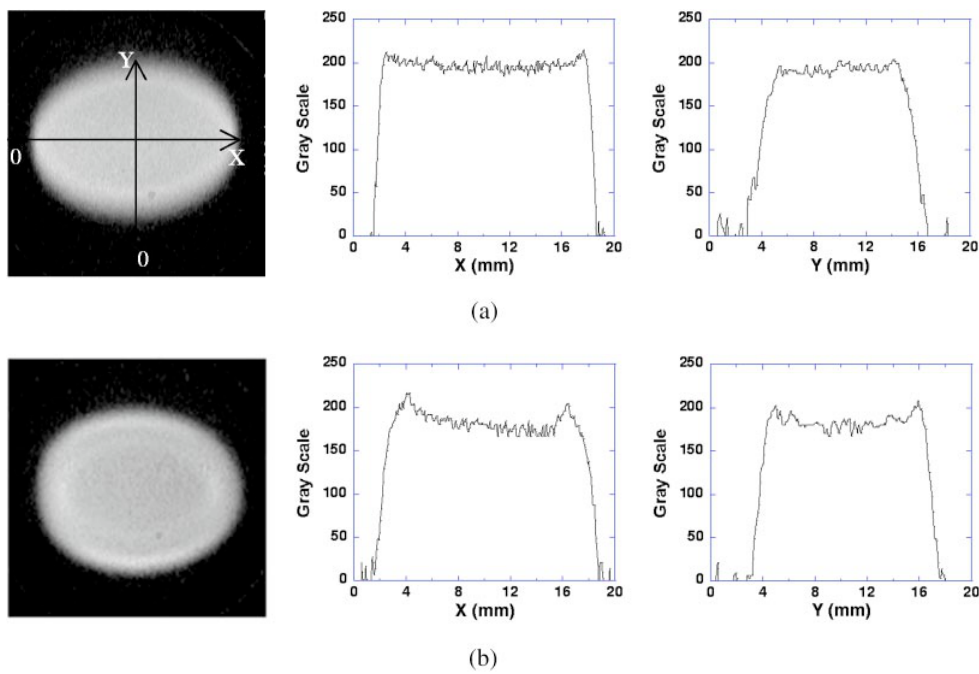
FIG. 4. (Color) Beam cross sections and density profiles near planes between quadrupoles 2 and 3 (a) and between quadrupoles 4 and 5 (b). The gray scale corresponds to an eight-bit picture, i.e., where “0” is black and “255” is